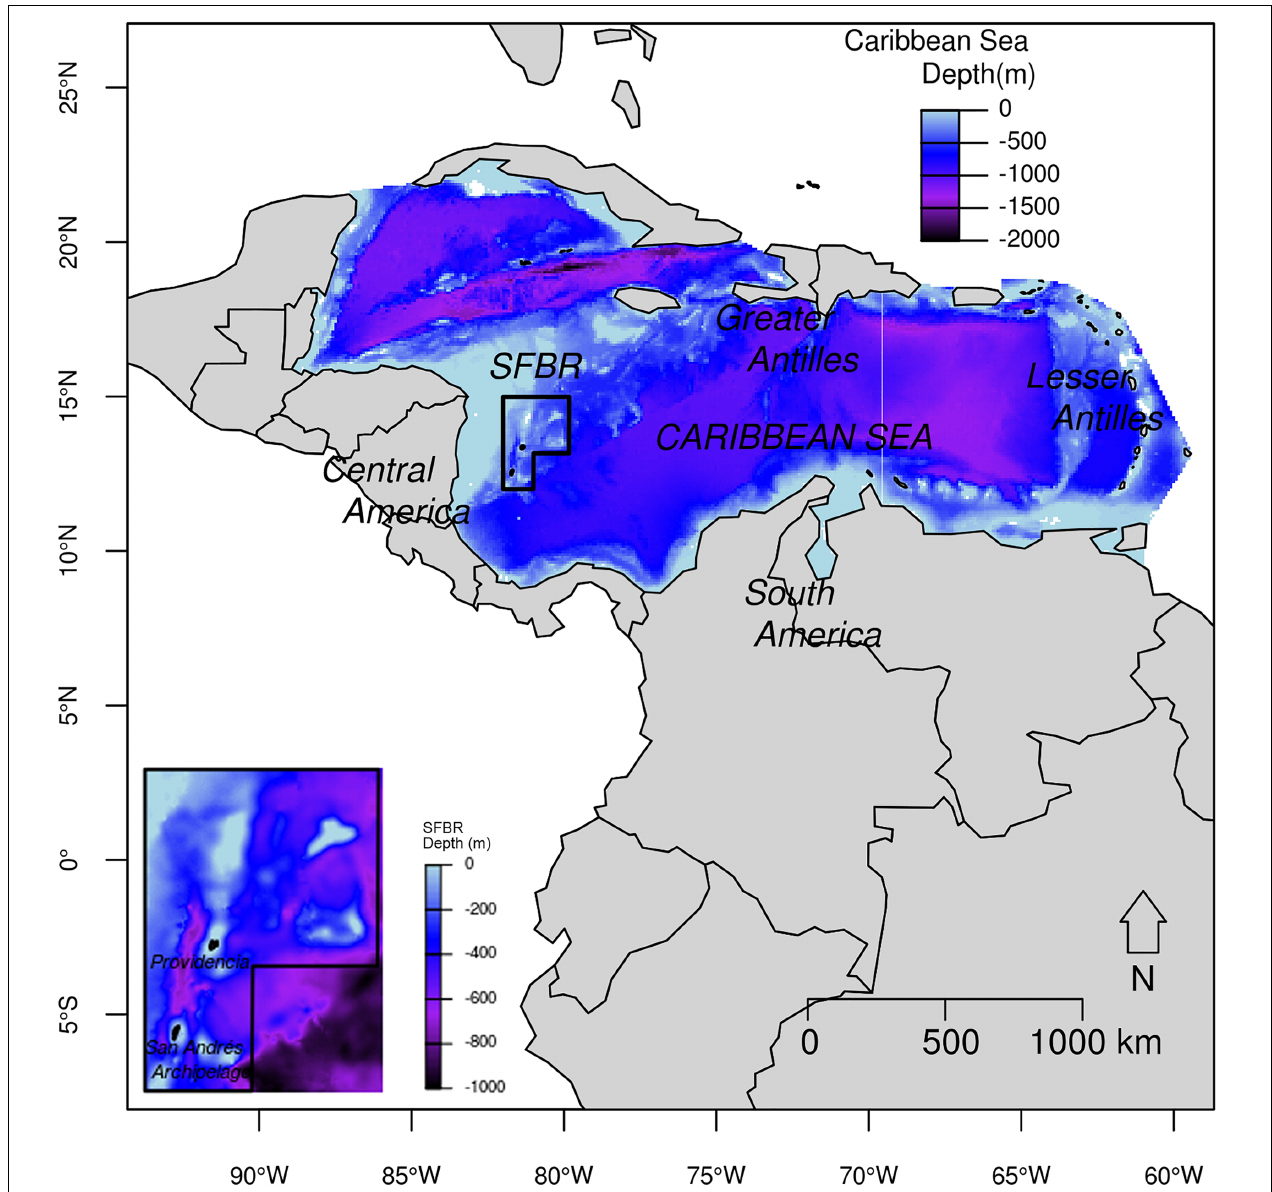
FIGURE 1 | Study area with the location of Seaflower Biosphere Reserve (polygon in bold black line). Inset provides a zoom in the Seaflower Biosphere Reserve and indicates the main